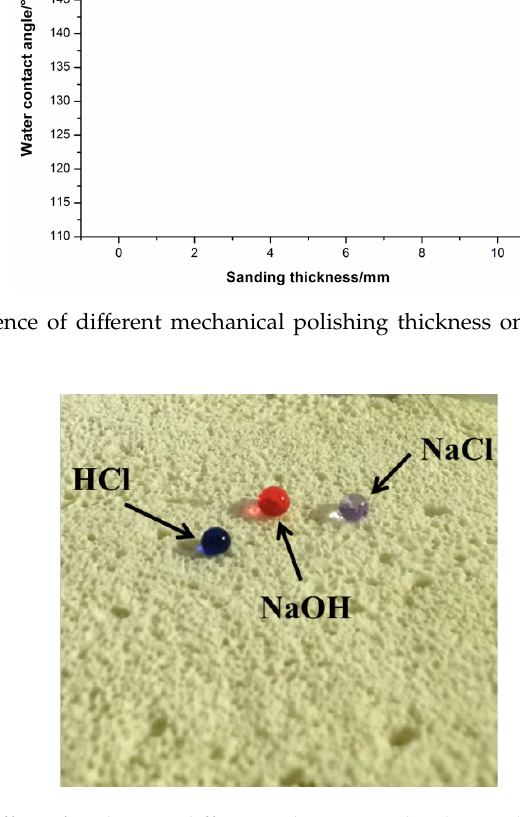
Figure 12. The effect of soaking in different solutions on the chemical stability of F-MOC.